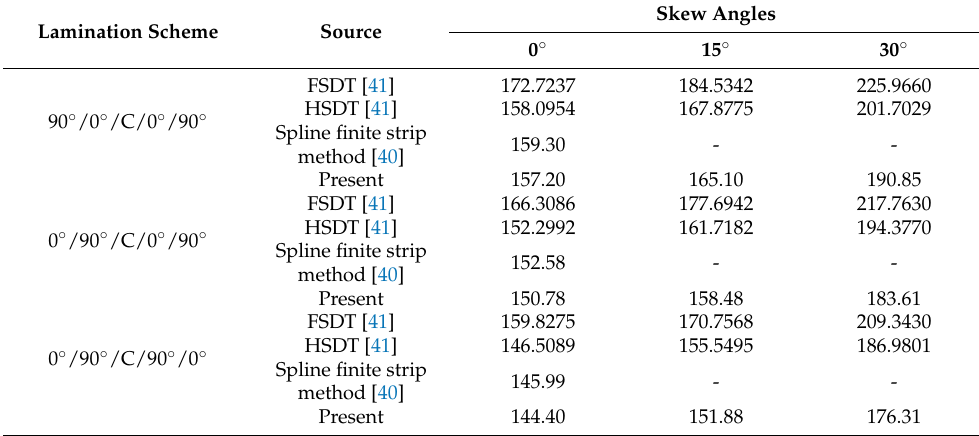
Table 4. Effect of skew angle on the fundamental frequency (Hz) of the LCS plate.